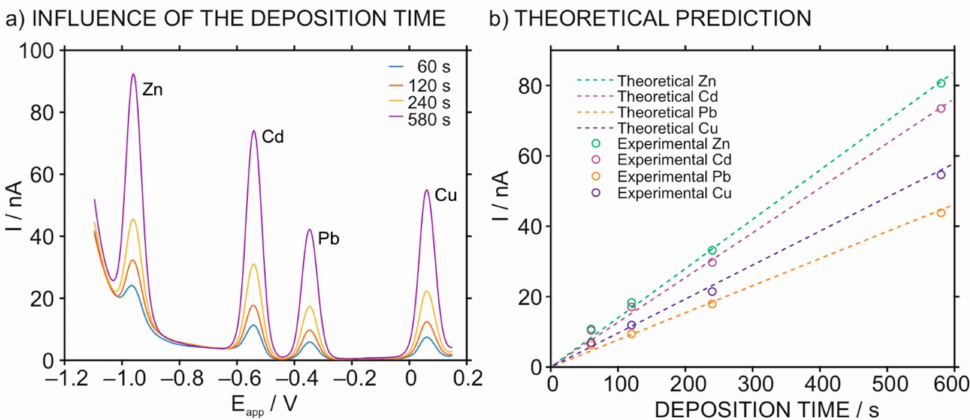
Figure 3. ( a ) Anodic stripping voltammograms for a solution containing 50 nM Zn 2+ , Cd 2+ , Pb 2+ , and Cu 2+ in HNO 3 at different deposition potentials. E d = − 1.1 V, t d = 120 s, t r = 30 s, E i = − 1.1 V, and E f = 0.15 V. ( b ) Comparison of experimental and theoretical peak current. Data was corrected by subtracting the baseline. Parameters employed in calculations: r 0 = 0.08 cm; w = 300 rpm; n = 2; t p = 0.025 s; ∆Ψ p = 0.9245; D M , Zn = 1.67 · 10 − 5 cm 2 s − 1 ; D M , Cd = 1.53 · 10 − 5 cm 2 s − 1 ; D M , Pb